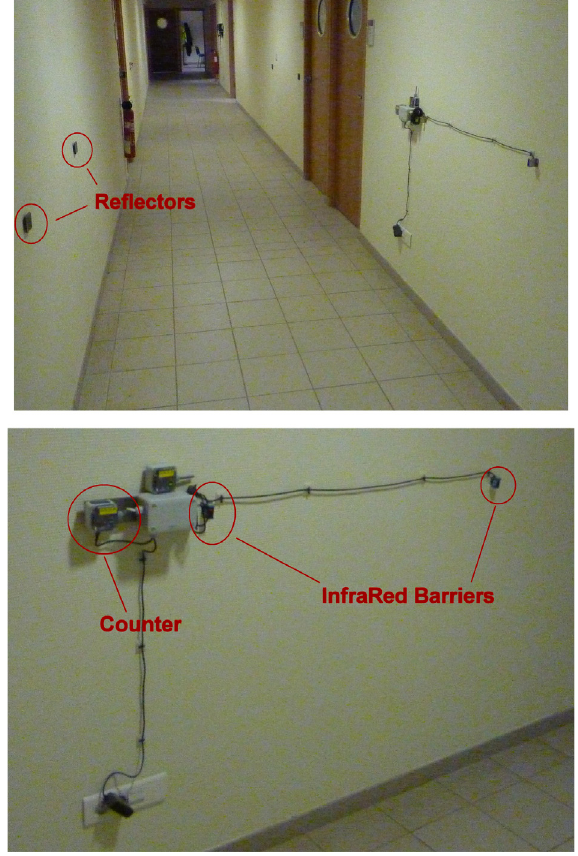
Fig. 3. Area inputs/outputs monitoring with Infrared